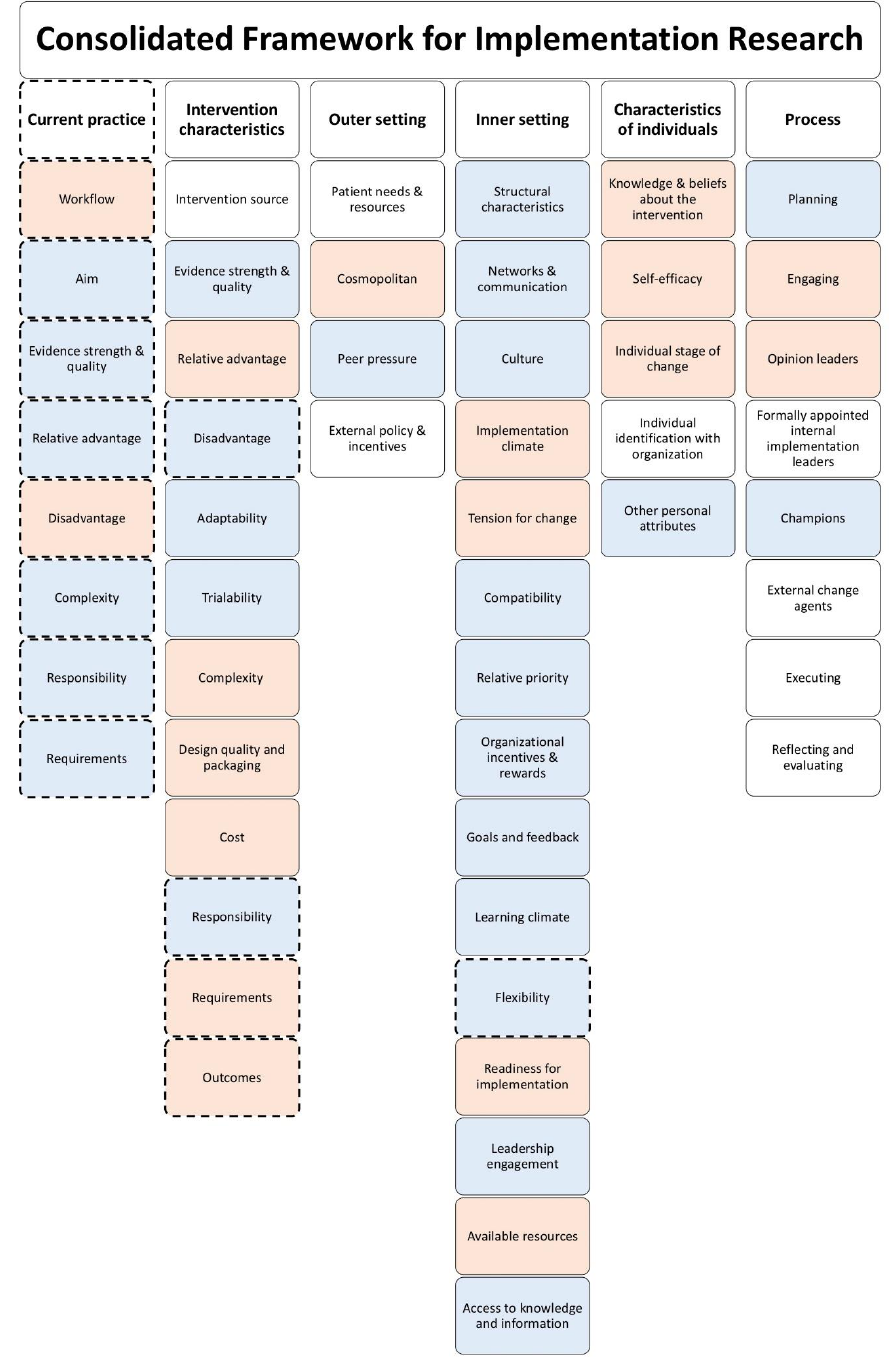
Figure 1. Overview of the elements of the final codebook and the components taken from the Consolidated Framework for Implementation Research (CFIR). The dotted boxes represent the domain and constructs added to the original CFIR codebook during analysis. The blue and orange boxes represent constructs that were initially captured by the interviewer during phase 2 of thematic analysis (44/53). The orange boxes represent barriers and facilitators identified as relevant for answering the research question (18/53). The blue boxes represent barriers and facilitators that were interesting but not necessary for answering the research